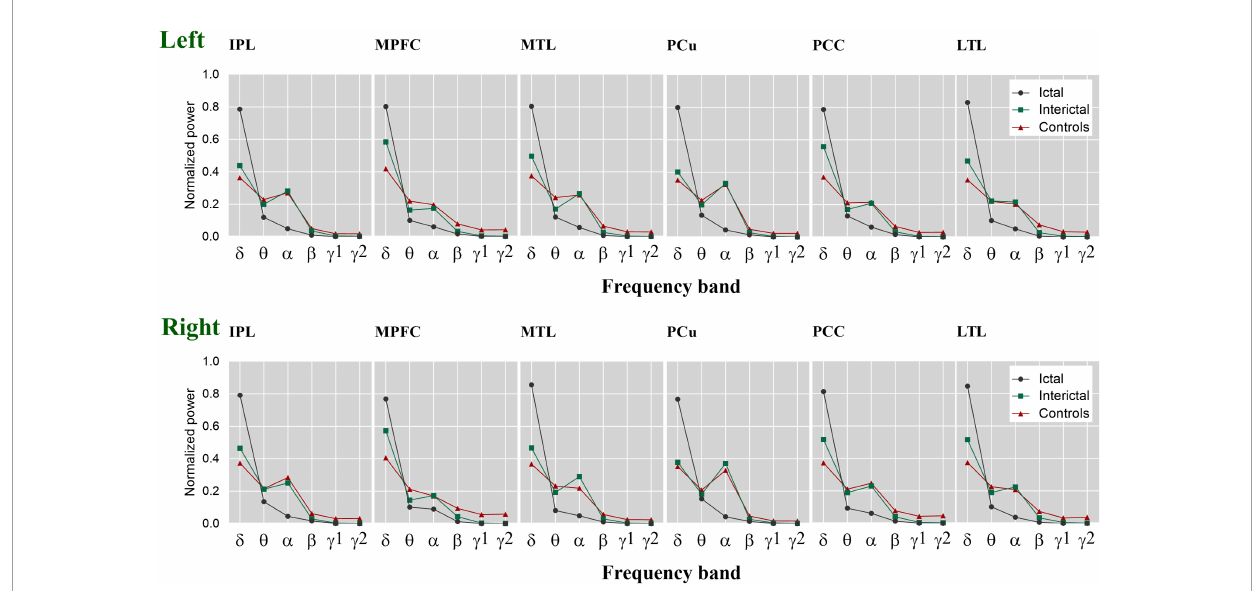
FIGURE3 The relative spectral power of each ROI within the DMN. The estimated normalized and averaged spectral power of 12 ROIs in six frequency bands across control, interictal and ictal data, respectively. δ , delta; θ , theta; α , alpha; β , beta; γ 1, gamma 1; γ 2, gamma 2. Left, left hemisphere. Right, right